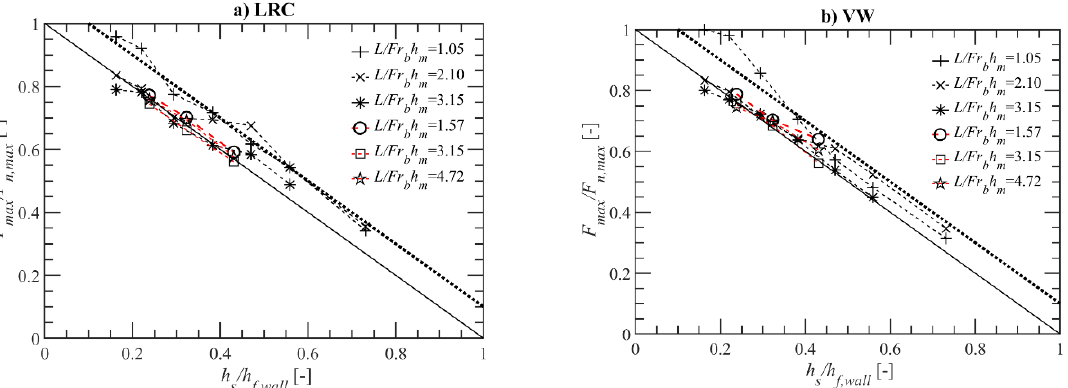
Figure 17. Effect of the height of the mitigation wall in force on the inland structure (black— d o = 0.9 m and red— d o = 0.6 m). The solid line portrays a linear reduction, while the dotted line portrays a 10% force increment from the linear reduction (upper bound).